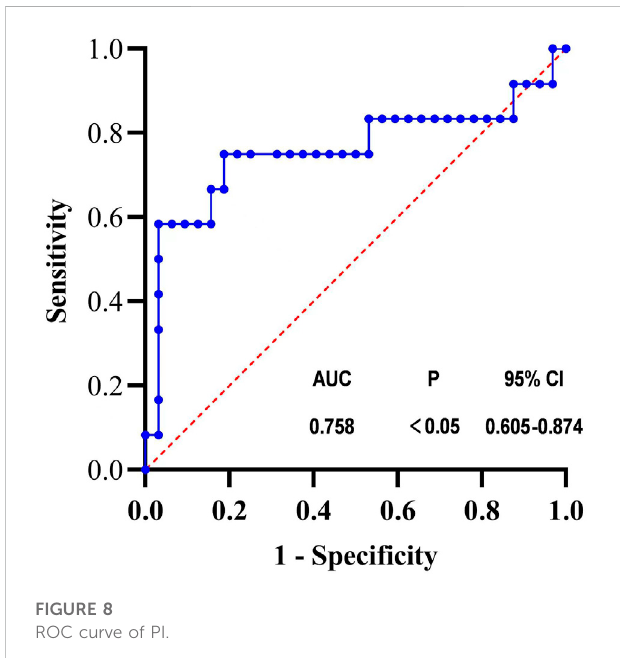
FIGURE 8 ROC curve of